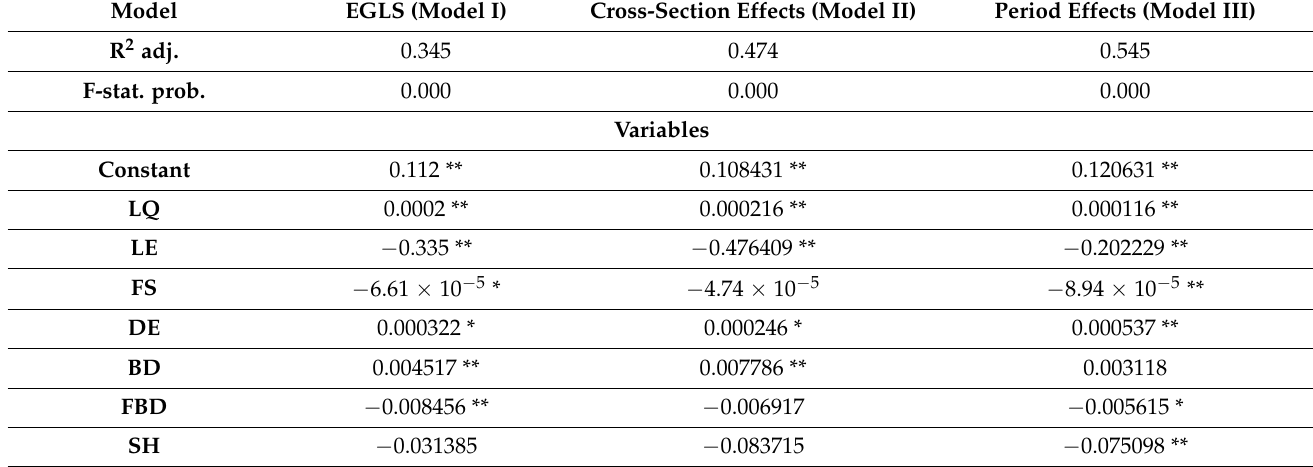
Table 1. Empirical